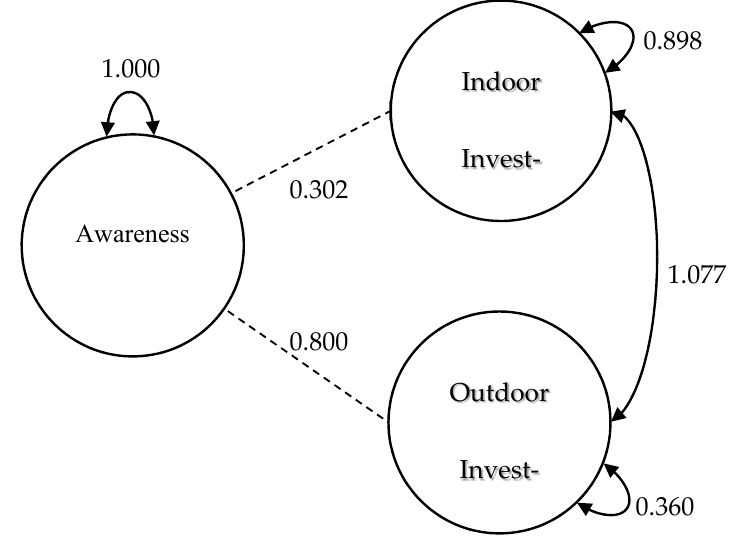
Figure 9. Model of owning water-saving appliances for indoor and outdoor usage regressed on awareness of water supplies for feedlot well owners ( n = 66).